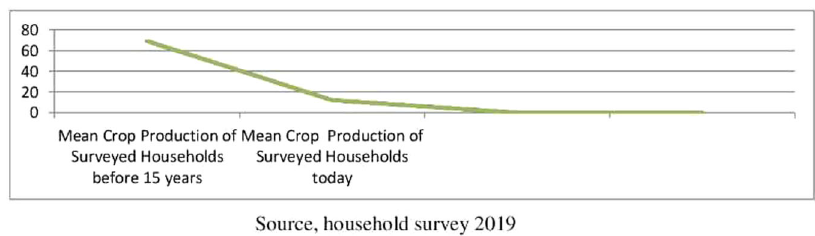
Fig. 5 Comparison of current mean crop production with before 15 years. Figure tried to show the current mean variation of surveyed households ’ agricultural production with the last 15 years. It stipulated the in fl uence of farms on the agricultural production of